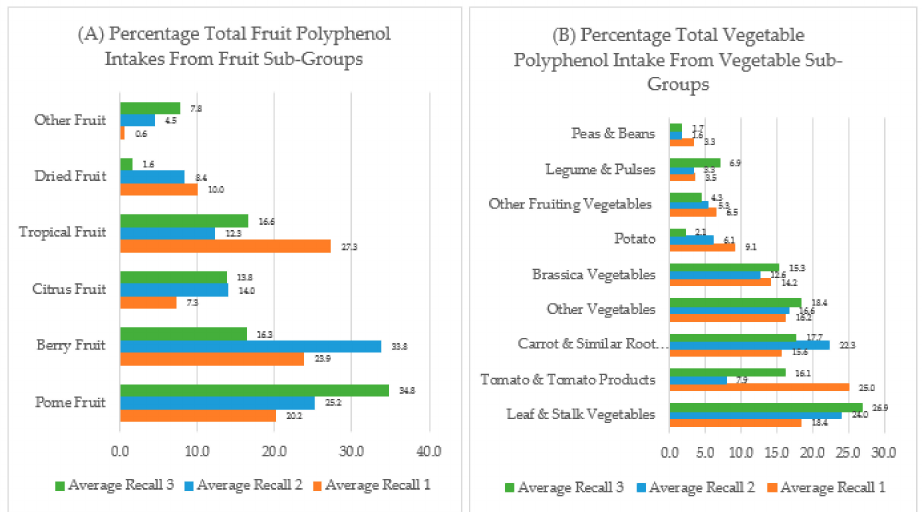
Figure 1. Percentage of total fruit or vegetable polyphenol intakes from sub-groups of fruit and vegetable intakes at baseline, week 2 and week 10. ( A ) Percentage of total fruit polyphenol intake from fruit sub-groups; ( B ) Percentage of total vegetable polyphenol intakes from vegetable